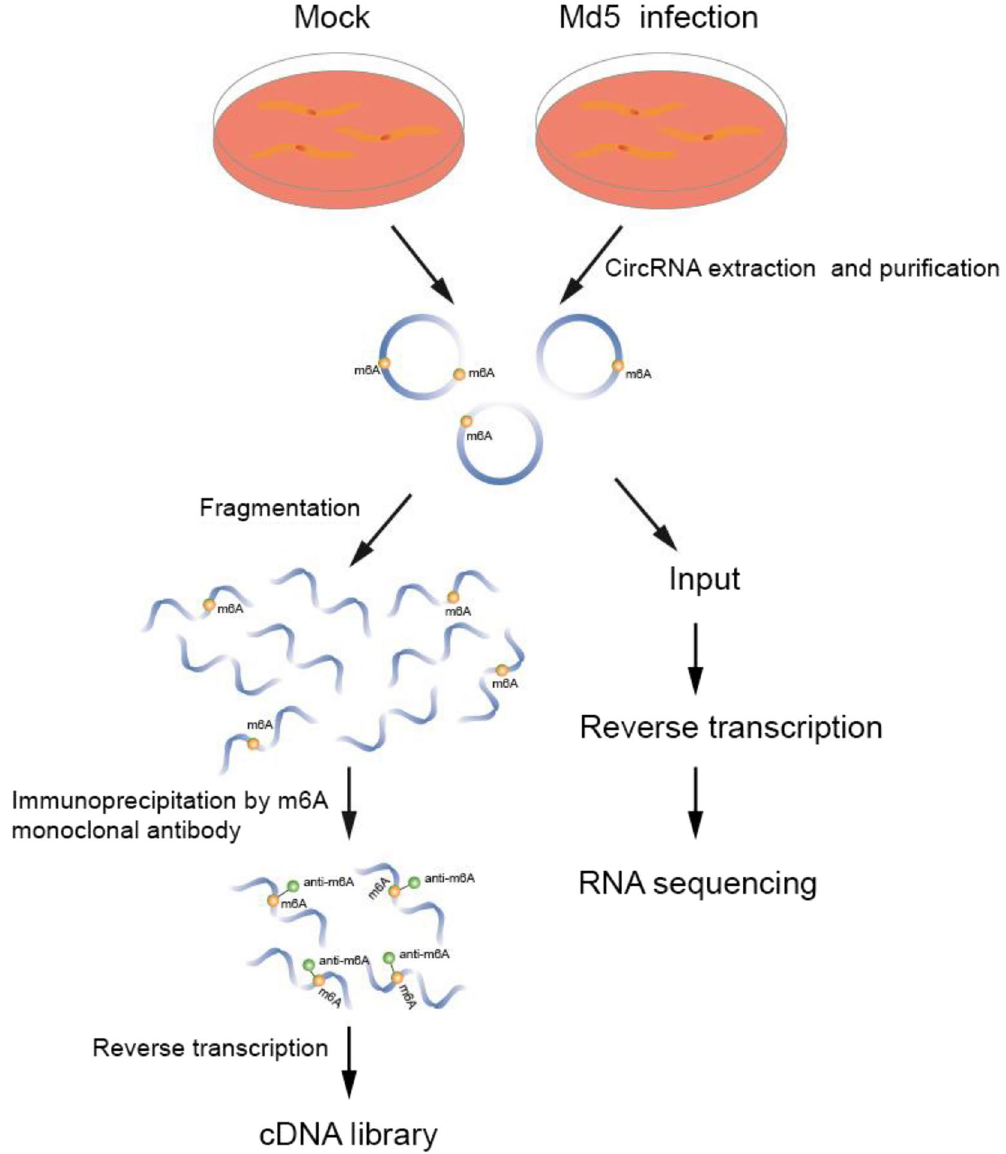
Figure 1. Flowchart depicting construction of cDNA libraries used for m 6 A-modified circRNA transcriptome sequencing of uninfected and Md5-infected CEF cells. (Figure was made by Adobe Illustrator, v 24.0, https:// www. adobe. com/ cn/ produ cts/ illus trator.